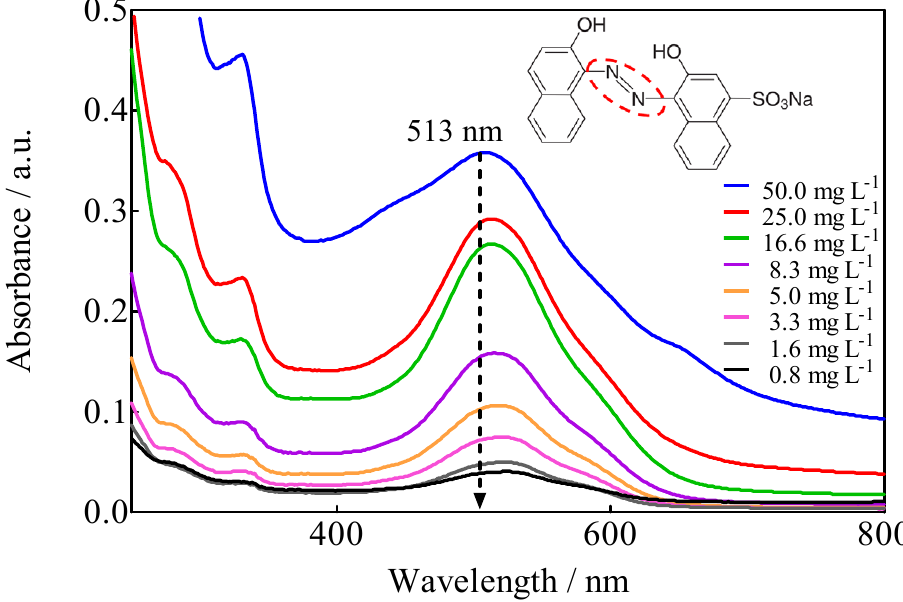
Figure 6. UV-vis absorption spectra, in adimensional units of absorbance, of 0.25 M H 2 SO 4 + x mg L − 1 Calcon solutions as a function of Calcon concentration, 0 < x ≤ 20 mg L − 1 .